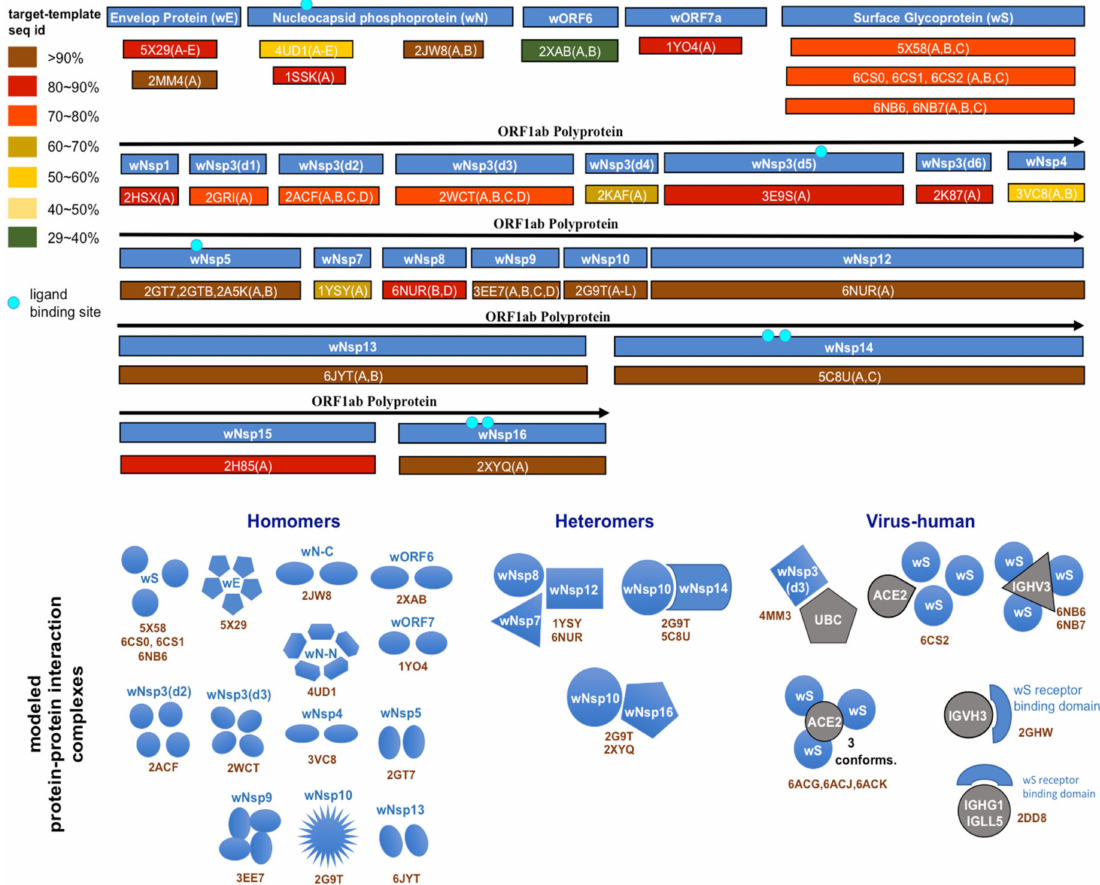
Figure 1. Structural genomics and interactomics road map. Shown are the individual proteins and protein complexes targeted for structural characterization together with PDB ID of their templates from the Protein Data Bank